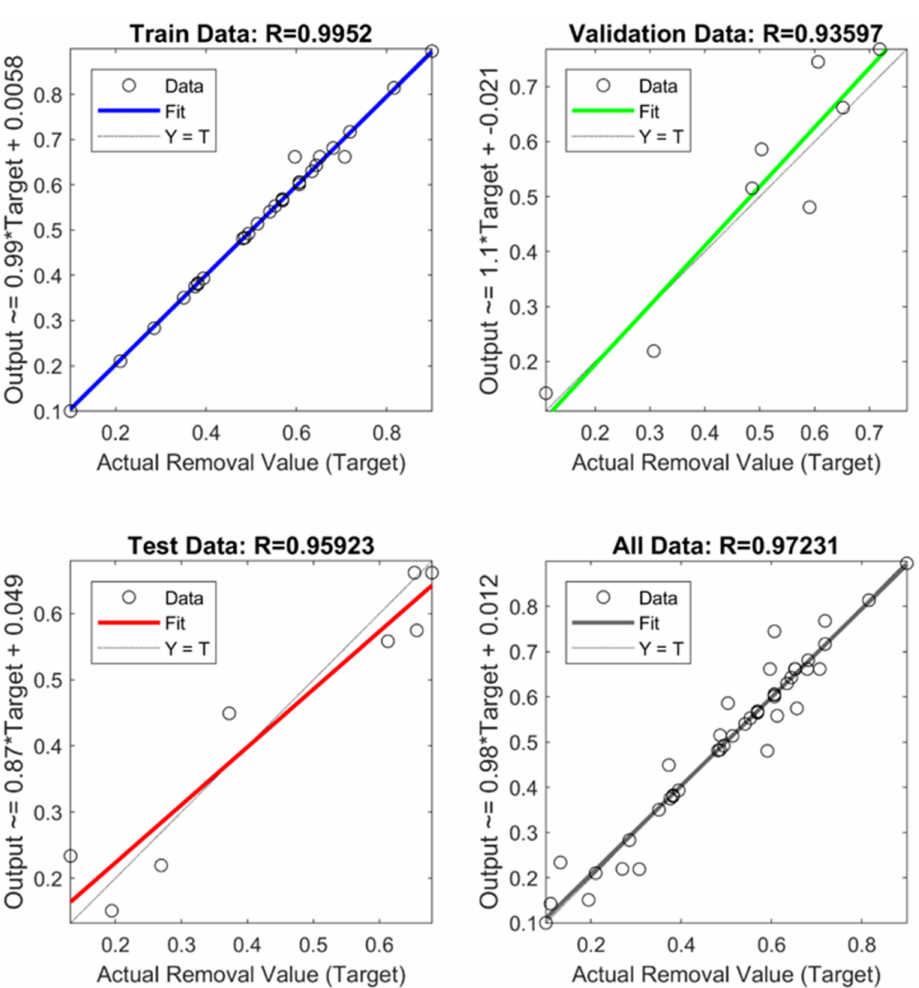
Figure 3. Scatter plots of the predicted and actual formaldehyde removal efficiencies in all the phases.